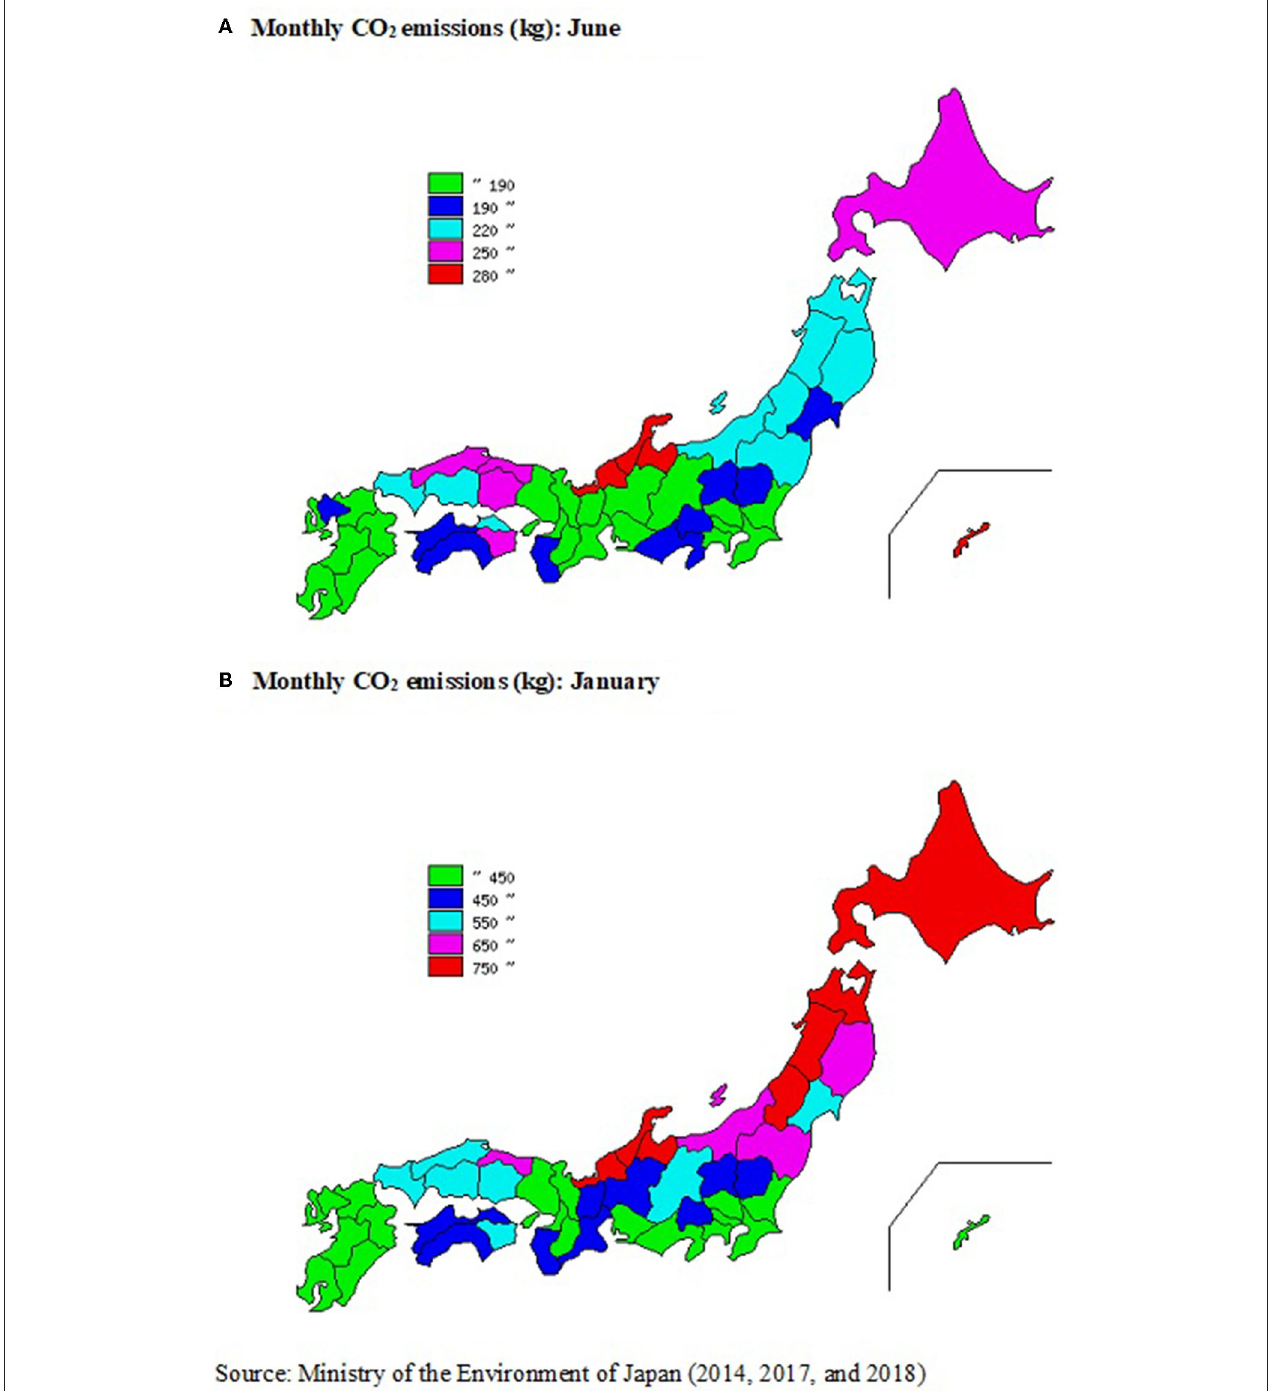
FIGURE 1 | (A) Monthly CO 2 emission (kg): June. (B) Monthly CO 2 emission (kg): January.